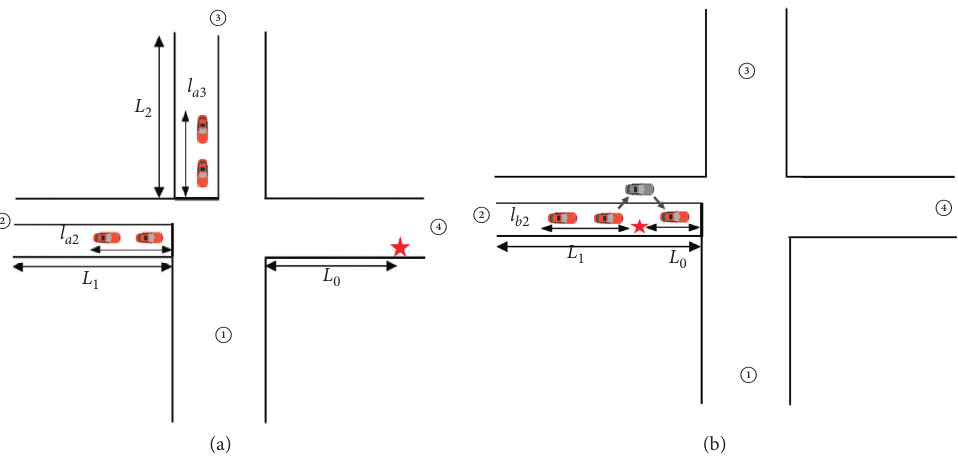
Figure 3: The queue length when traffic incidents occur in (a) No. 4 departure and (b) No. 2